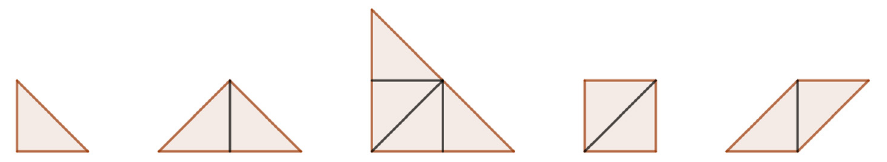
Figure 2. The Tangram pieces covered by the smallest triangle.